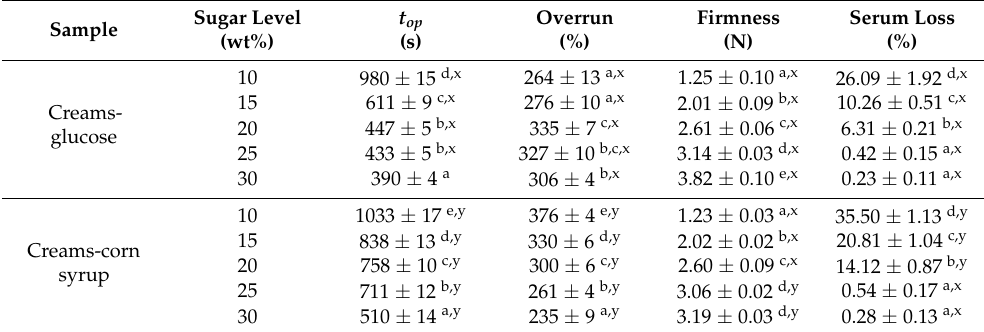
Table 1. Whipping properties and serum loss of whipped creams with addition of different sugars at different